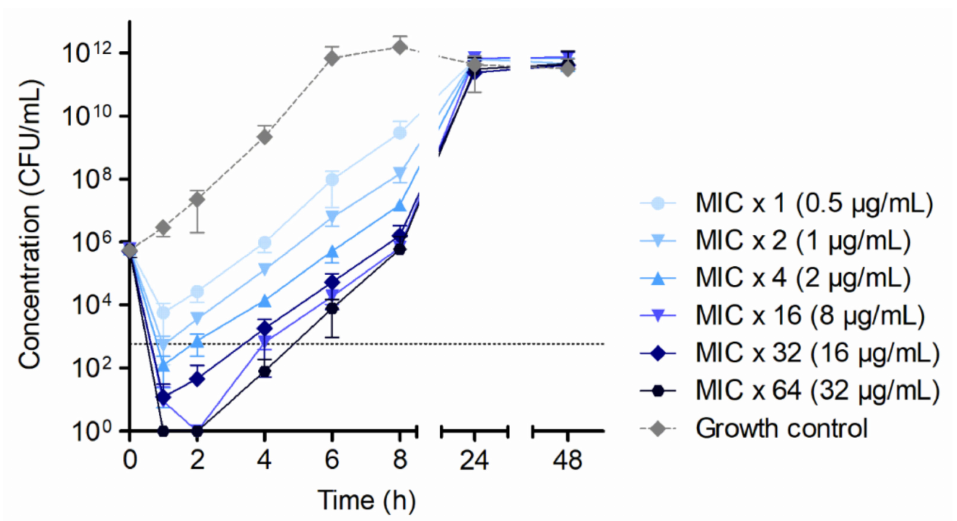
Figure 1. Time–kill curves applying different HY-133 concentrations against S. aureus strain ATCC 29213 showing killing and subsequent bacterial re-growth. Plot shows mean values for log 10 of the numbers of CFU/mL versus time. The threshold (dotted line) implicates the ≥ 3 − log 10 decrease in CFU/mL. Time–kill curves were performed in triplicate (mean ± standard deviation). A culture of S. aureus strain ATCC 29213 without HY-133 was always included as a growth control (dashed line).